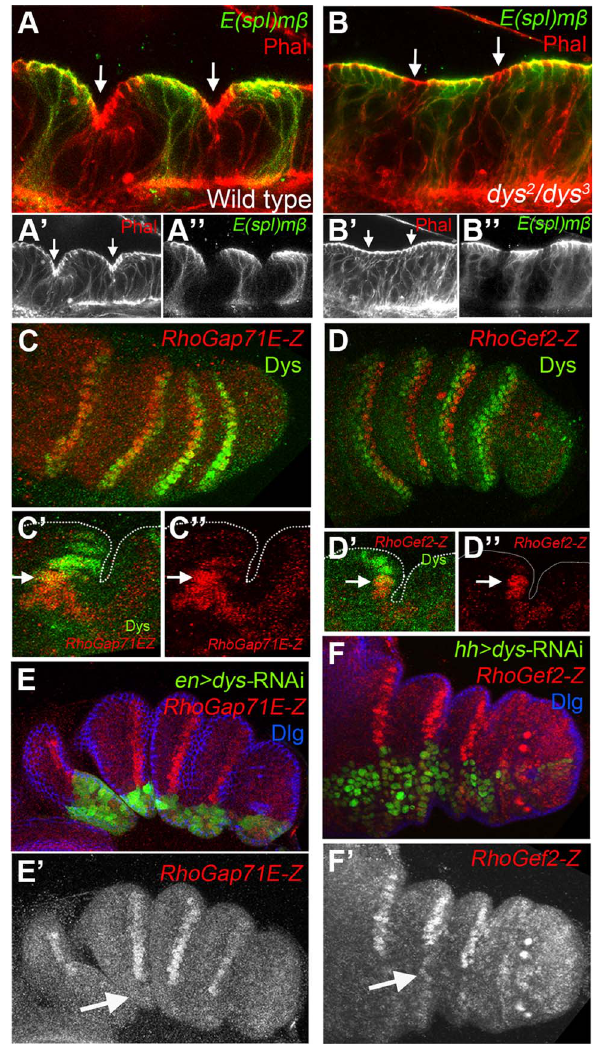
Figure 4. dys is required for fold formation and for the expression of RhoGap71E and RhoGef2 . (A and B) Sagittal view of a wild type (A) and dys 2 /dys 3 (B) prepupal leg disc epithelium, stained with Phallodin (Phal) (red) and E(spl)m b -CD2 (green). The joints between tarsal segments 2/3 and 3/4 are shown in A (arrows), and the corresponding region in B (arrows). Note the apical constriction in cells immediately distal to the E(spl)m b -CD2 expression domain in the wild type leg and its absence in dys 2 /dys 3 mutant legs. Single channels for Phal (A 9 and B 9 ) and E(spl)m b -CD2 (B 9 and B 0 ) are displayed below. (C and D) RhoGap71E-Z (C, red) and RhoGef2-Z (D, red) expression compared to Dys (green). (C 9 and D 9 ) Sagittal view of a single joint where the last dys expressing cell is marked by an arrow. Note that both genes, RhoGap71E-Z and RhoGef2-Z , are expressed in a single row of Dys-positive cells and in a row of adjacent Dys-negative cells. (C 0 and D 0 ) Single channels for RhoGap71E-Z and RhoGef2-Z . (E) en-Gal4 , UAS - GFP ; UAS- dys -RNAi (green) and (F) hh-Gal4 , UAS -GFP ; UAS- dys -RNAi (green) downregulates RhoGap71E-Z and RhoGef2-Z expression (red, arrows), respectively. Dlg is in blue. Single channels for RhoGap71E-Z (E 9 ) and RhoGef2-Z (F 9 ) are displayed below.